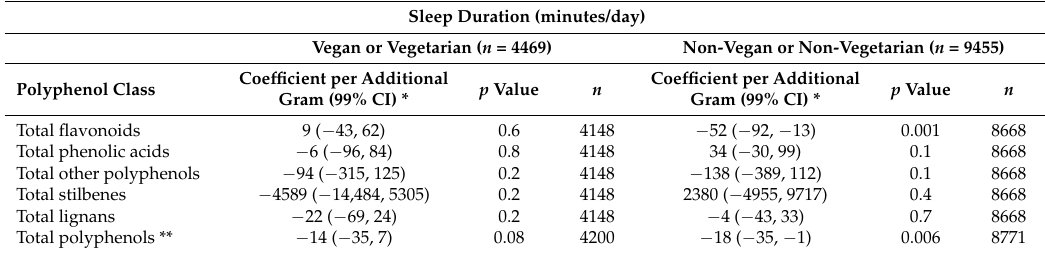
Table A3. Prospective associations between polyphenol content from fruit and vegetable intakes and sleep duration for women from the UKWCS stratified by vegan/vegetarian status.